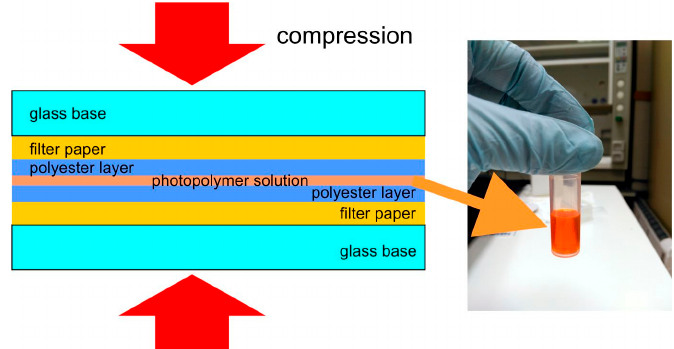
Figure 3. Preparation of the sample by compression of the photopolymer solution inside the layer sandwich.